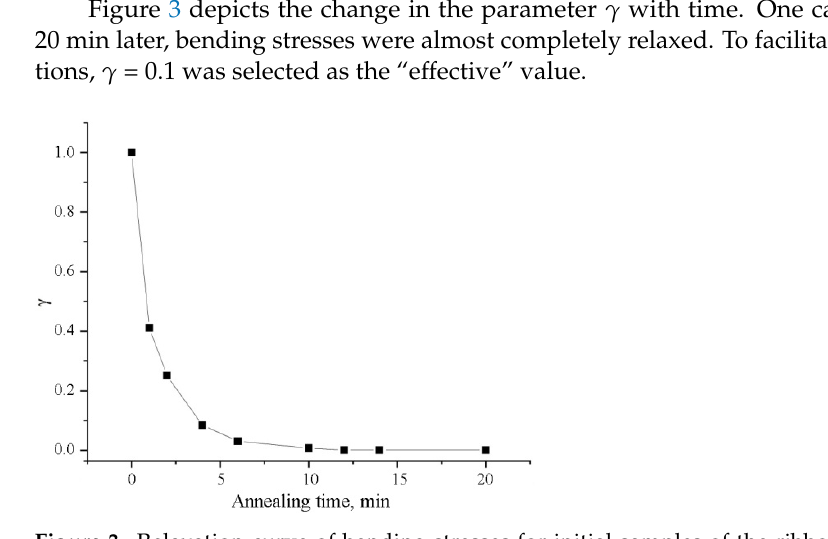
Figure 3. Relaxation curve of bending stresses for initial samples of the ribbon under annealing at 753 K.